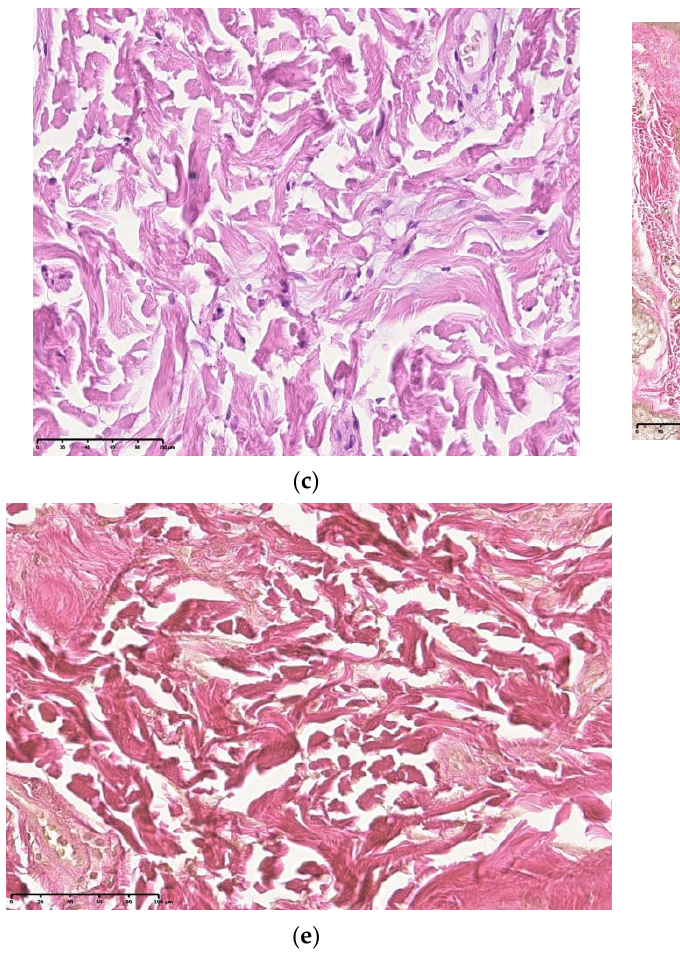
Figure 5. Micrography of the skin section in the main group is an intact skin area of patients with premature skin aging: ( a – c ) stained with hematoxylin and eosin, ( d , e ) stained according to the Van Gieson method. ×100 ( a , b , d ), ×200 ( c , e ).